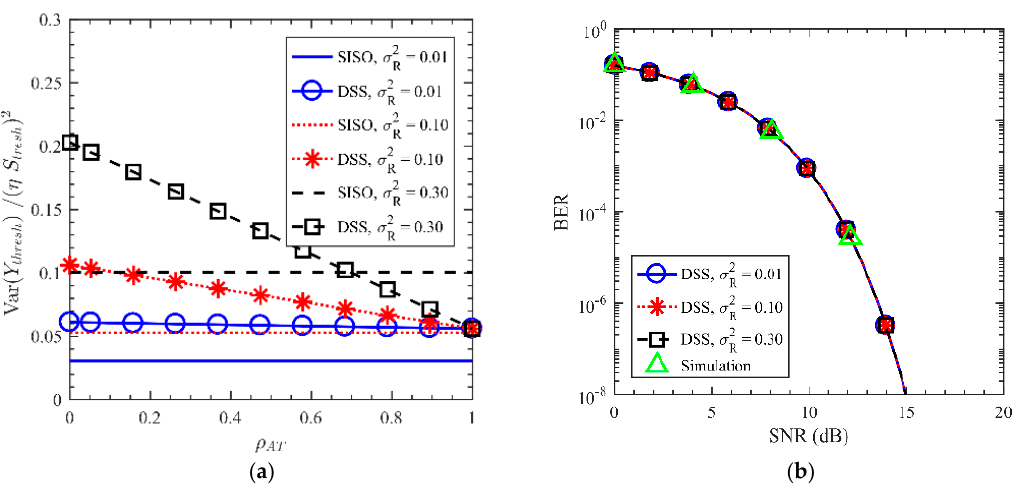
Figure 2. Single-input single-output (SISO) and differential signaling scheme (DSS) based free-space optical (FSO) links with weak turbulence: ( a ) the normalised variance of detection threshold level (DTL) versus the correlation coefficient of the channels; and ( b ) bit-error-rate (BER) against signal-to-noise ratio (SNR) for a range of σ 2 R